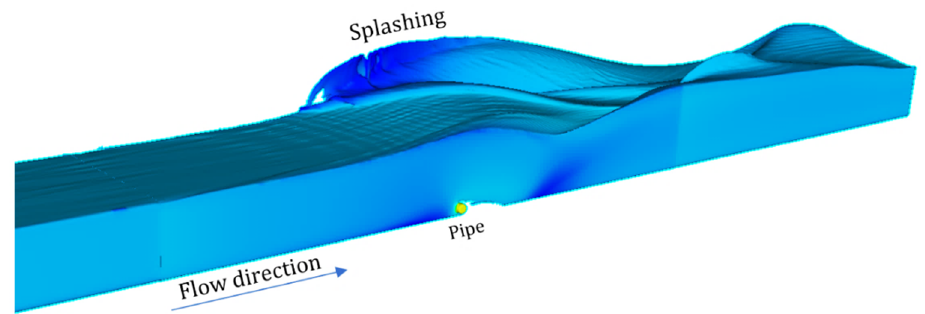
Figure 26. Back-water effect in a channel with sub-critical flow.